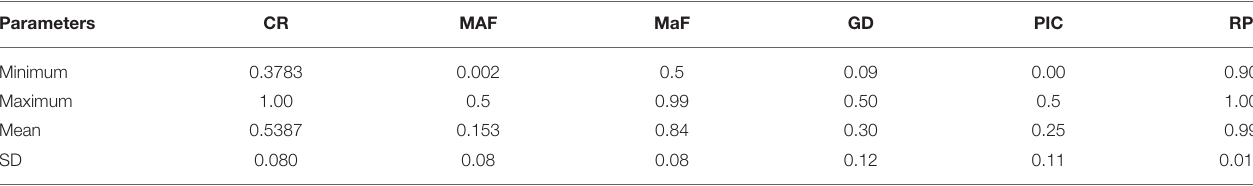
TABLE 1 | Genetic properties of markers.